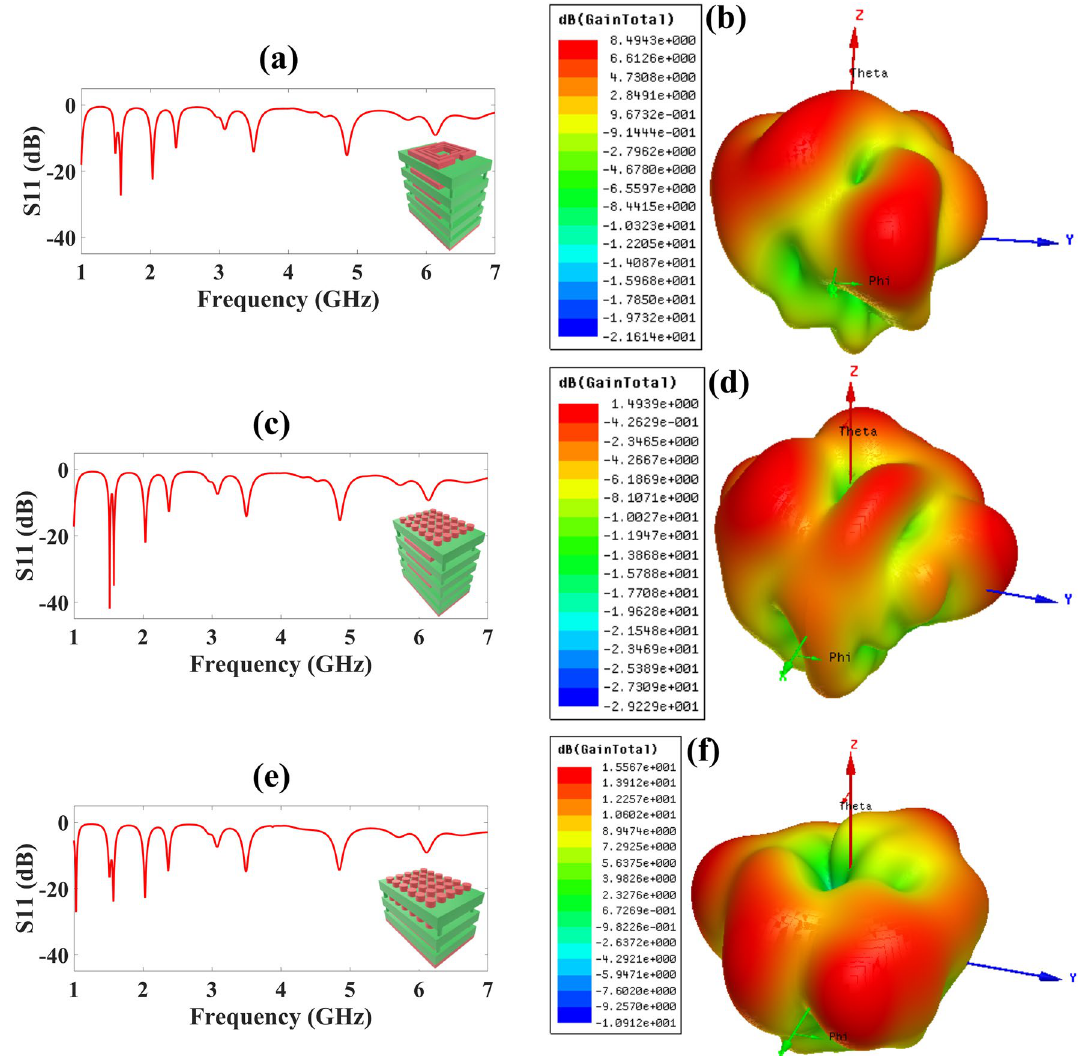
Figure 4. Simulated results of reflectance response (S 11 ) and 3D Gain polar plot for various superstrate structures (a) SRR four layer superstrate structure, five frequency bands are attained, (b) for SRR four layer superstrate structure highest gain of 8.49 dB is attained, (c) for SRR three layer combined with 6 × 5 TW single layer as a top layer, we attain five frequency bands, (d) for SRR three layer combined with 6 × 5 TW single layer as a top layer, highest gain of 1.49 dB is attained, (e) for 6 × 5 TW double layer superstrate structure, six frequency bands are attained. (f) for 6 × 5 TW double layer superstrate structure, highest gain of 15.57 dB is